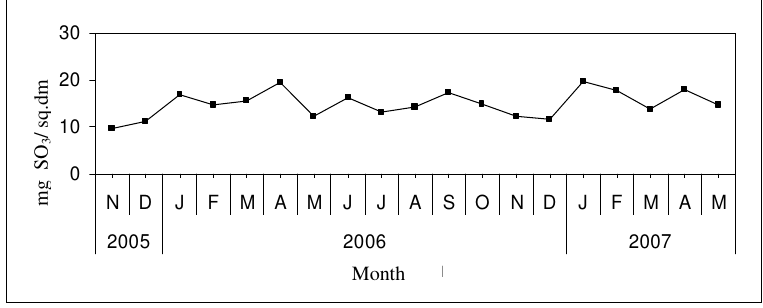
Figure 3 . Sulphation rate at marine